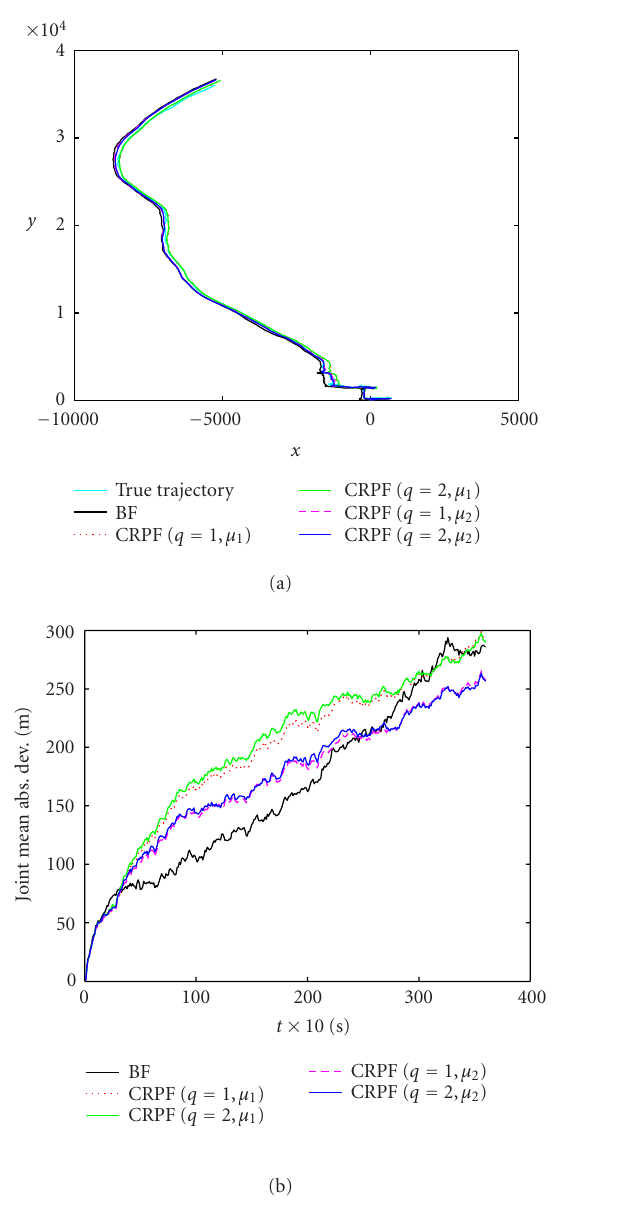
Figure 5: Di ff erent δ values. T s = 5 seconds. (a) Trajectory. (b) Mean absolute